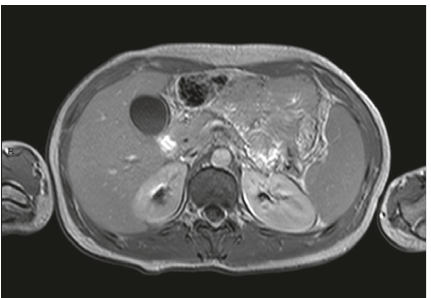
Figure 1: MRI showing normal spleen.